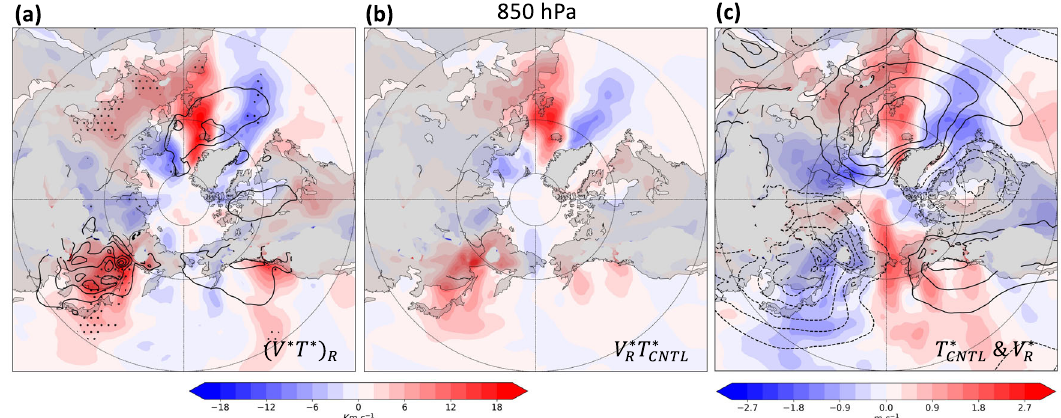
Fig. 5 Components of poleward eddy heat fl ux. Poleward eddy heat fl ux in CNTL (line) and its response ( R ) to sea ice forcing ( fi lled) ( a ) and T (cid:1) in ( b ). The underlying eddy fi elds of T (cid:1) (line; in K) and V (cid:1) ( fi lled; in m s − 1 ) are in ( c ) at 850 hPa. decomposed poleward eddy heat fl ux V (cid:1) R CNTL CNTL R All variables are averaged from day − 10 to day − 1 prior to the onset. The line contour interval is 20 K m s − 1 in ( a ) and 2 K in ( c ). Stippling in ( a ) indicates statistical signi fi cance at the 95% level. the SSW onset. As a product between the eddy meridional wind contours. Before the SSW onset, the CNTL poleward eddy heat fl ux and eddy temperature fi elds (i.e., V * T * ), the meridional eddy heat is most dominant over the Northwestern Paci fi c between 40°N fl ux is proportional to the local vertical wave activity. A positive and 60°N. The imposed sea ice loss signi fi cantly enhances this (i.e., poleward) eddy heat fl ux corresponds to local upward wave dominant heat fl ux region, leading to an enhanced upward wave activity. Fig. 5a shows the CNTL eddy heat fl ux as line contours activity over the Northwestern Paci fi c near 130°E (panel a). Along and the eddy heat fl ux response to the sea ice loss, ( V * T * ) R , as fi lled the 60-degree latitude circle, other weaker patches of CNTL